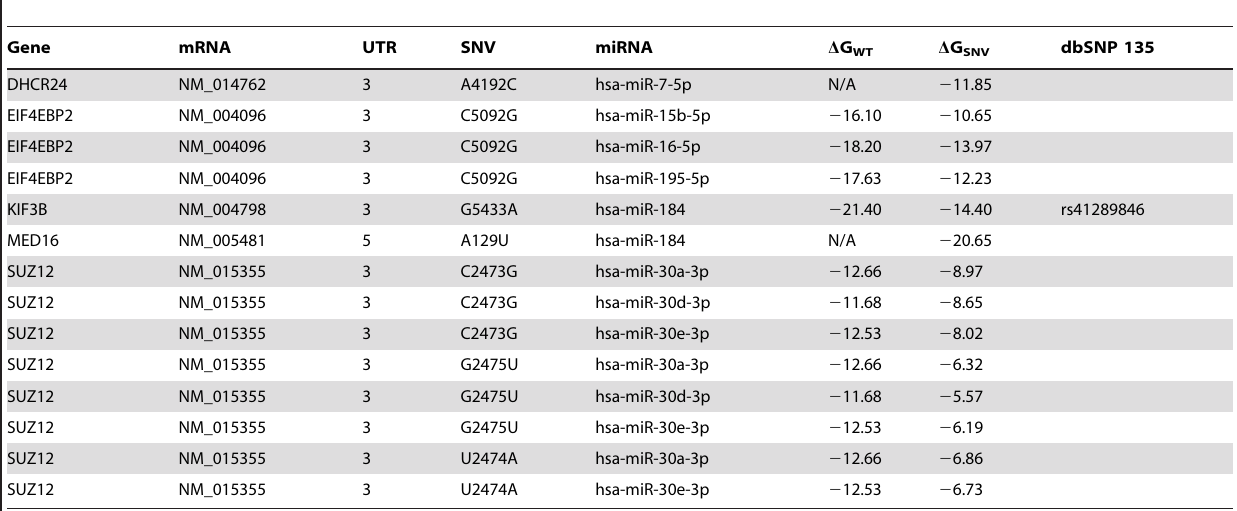
Table 5. List of target predictions of NCSLC-associated miRNAs derived from the microRNA body map [45].